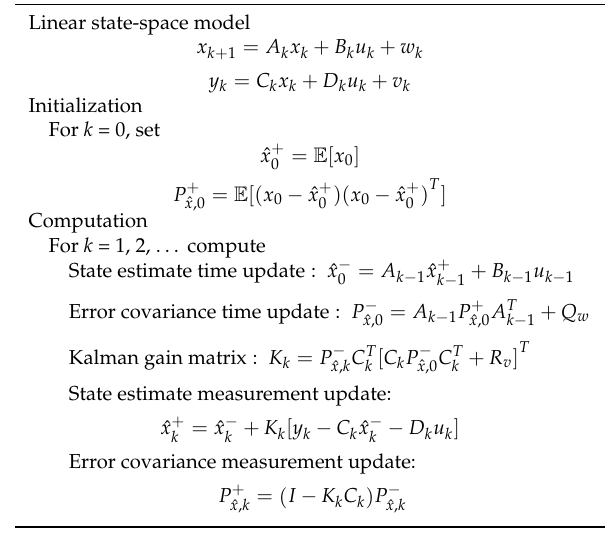
Table 2. Kalman filter algorithm [51].